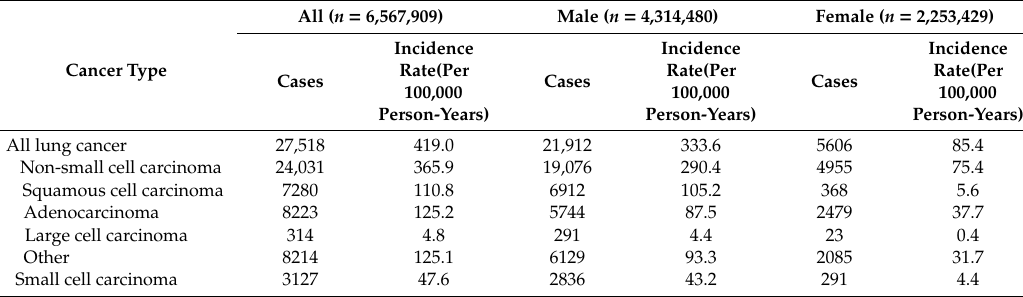
Table 3. Lung cancer incidence by histologic classification of study